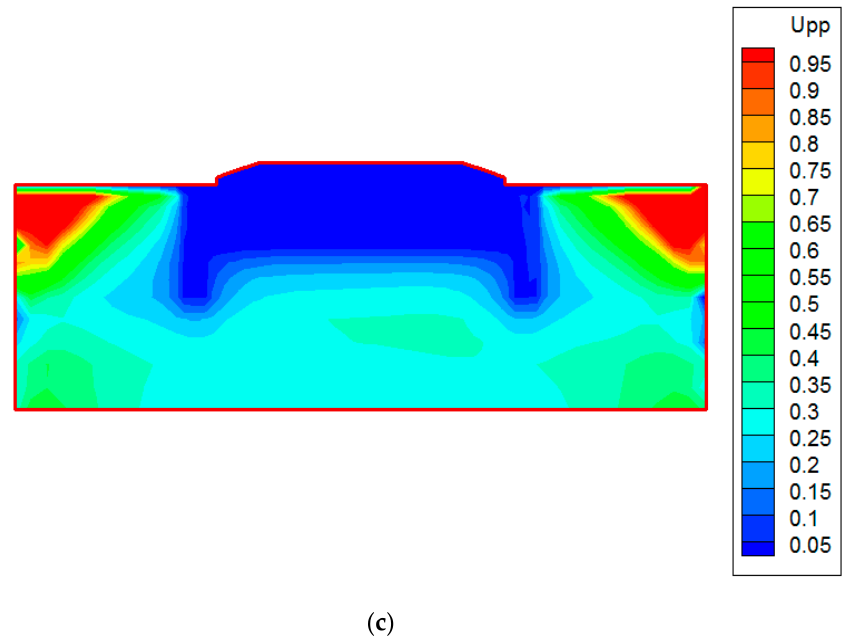
Figure 12. Distribution of excess pore pressure ratio at 20 s in natural foundation and reinforced foundations. ( a ) Natural foundation. ( b ) Foundation reinforced with isometric gravel piles. ( c ) Foundation reinforced with long-short gravel piles.